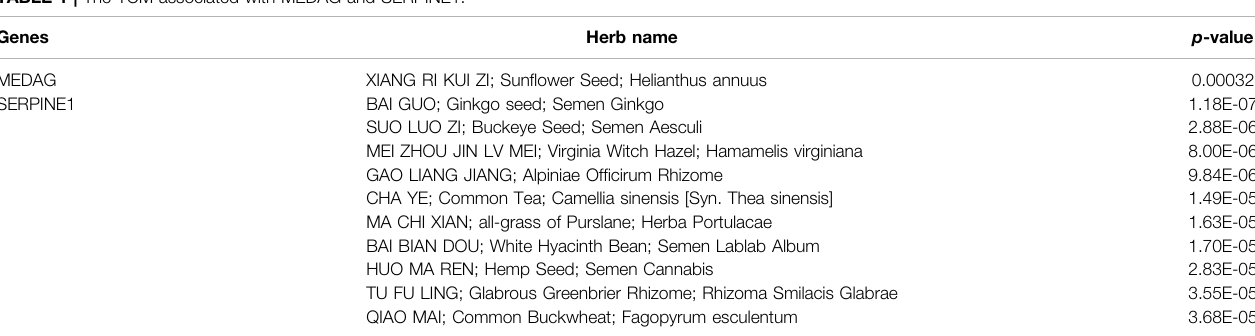
TABLE 1 | The TCM associated with MEDAG and